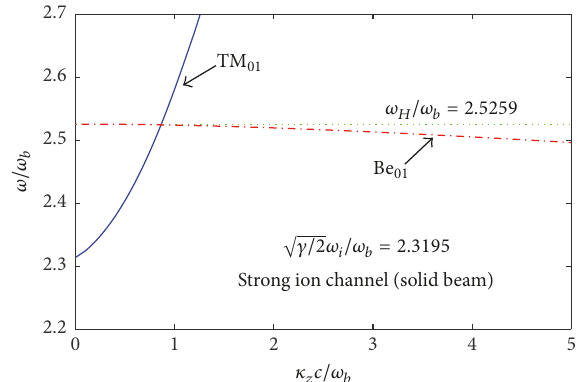
Figure 14: In annular beam case, there is no coupling between the TM modes and ES waves in weak ion channel case. The inner and outer radius of the annular beam are taken as 𝑎 = 0.25𝑅 and 𝑏 = 0.5𝑅 ; the Lorentz factor is 𝛾 = 6 .